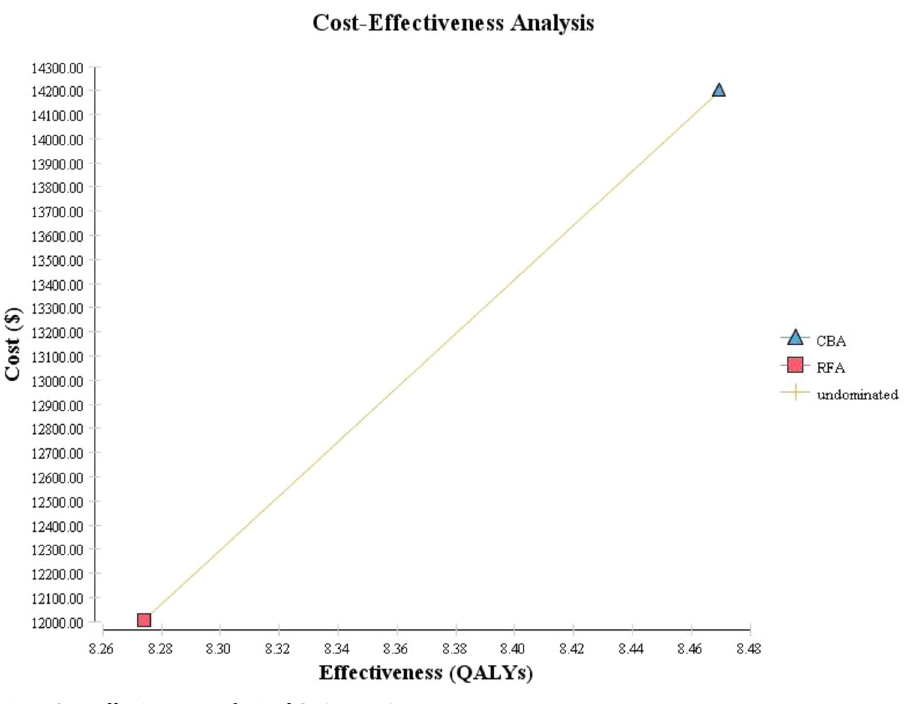
Fig 2. Cost-effectiveness analysis of CBA vs RFA.